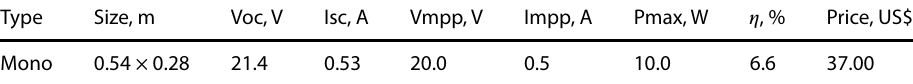
Table 2 Electrical specification of the PV